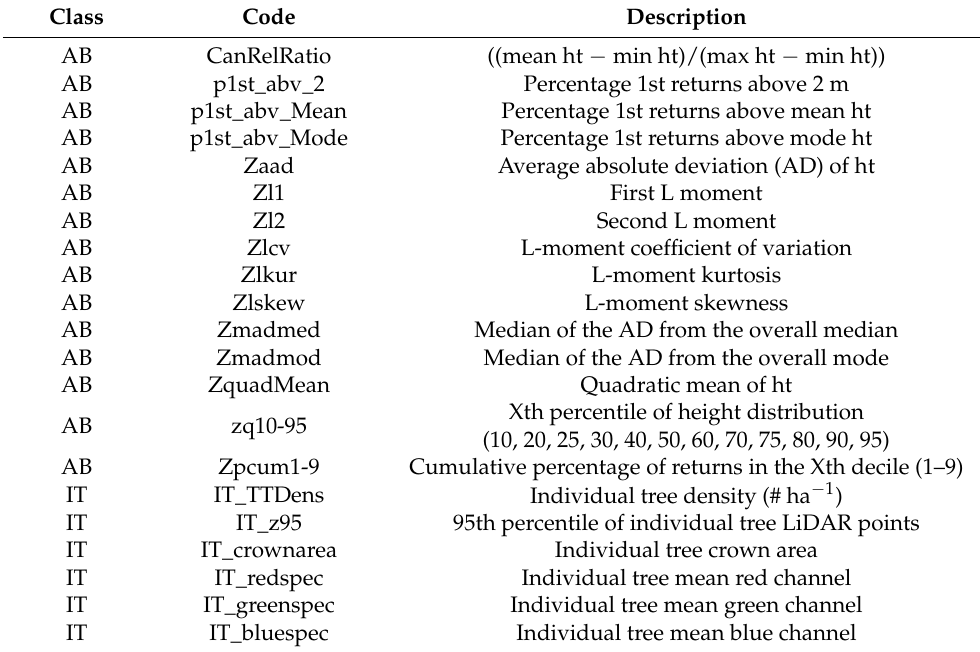
Table 3. Area based (AB) and individual tree (IT) style predictor metrics used for variable